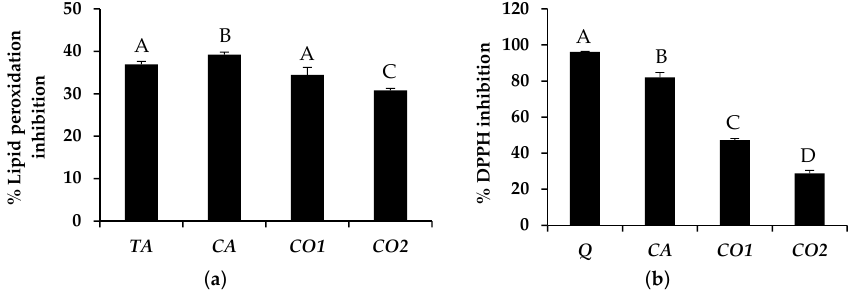
Figure 1. ( a ) Lipid peroxidation inhibition; ( b ) DPPH inhibition of tocopheryl acetate ( TA ), quercetin ( Q ), CA , CO 1, and CO 2 at the concentration of 37.5 mg/mL (different letters (A, B, C, and D) denote significant statistically differences between groups; p <